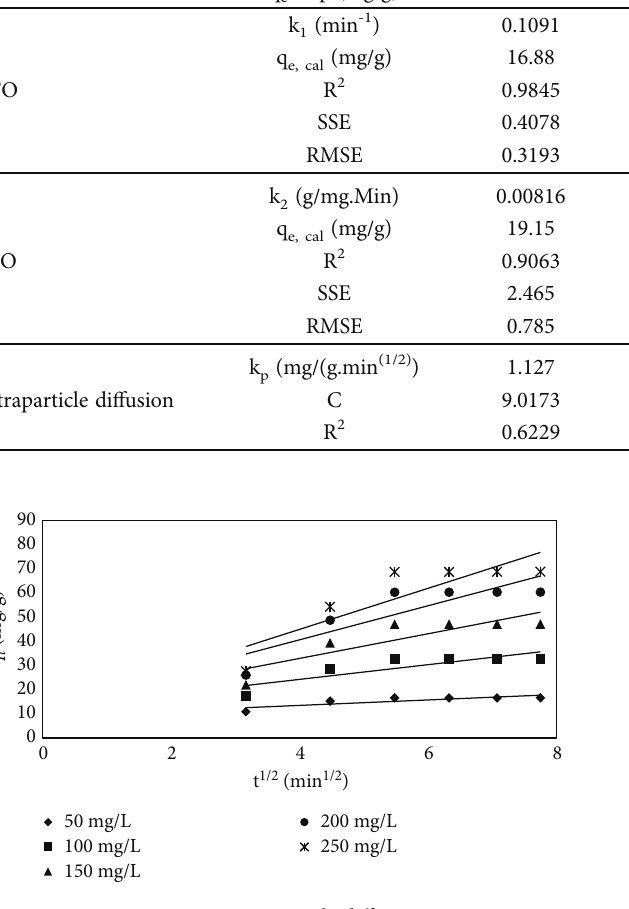
Figure 15: Intraparticle di ff usion.